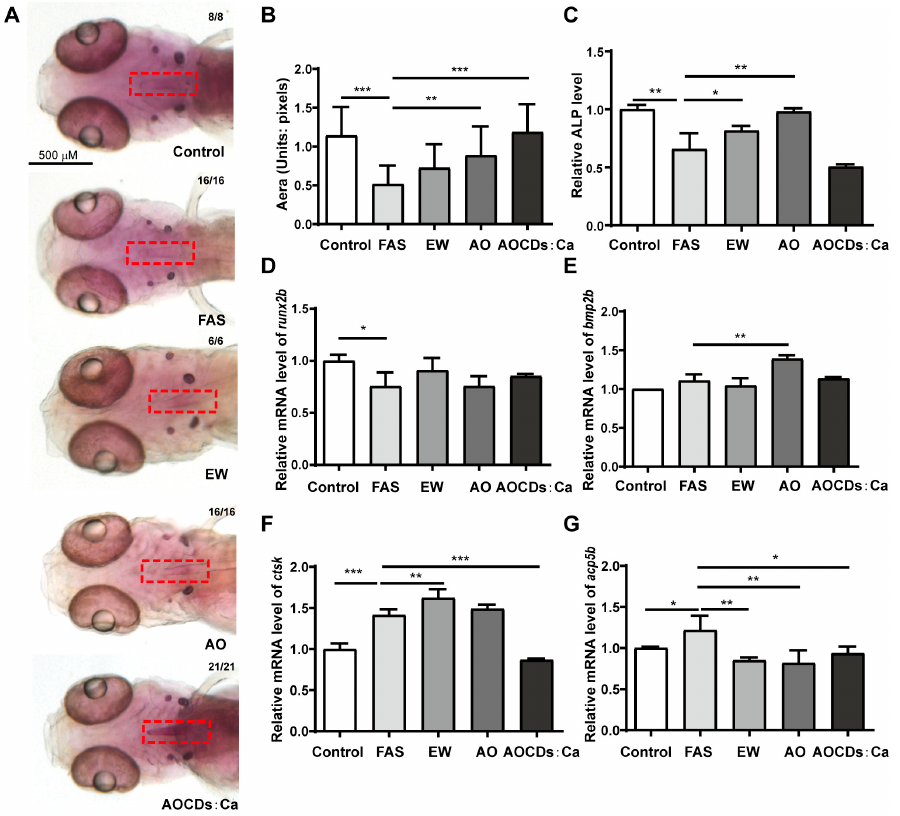
Figure 5. AOCDs:Ca treated iron overload osteoporosis by calcium supplementation. ( A ). Alizarin red staining., The red rectangle is the location of osteoporosis. ( B ). Numerical analysis of staining area (unit: pixel), ( C ). The content of ALP, Effect of treatment on genes osteoblast-regulated genes